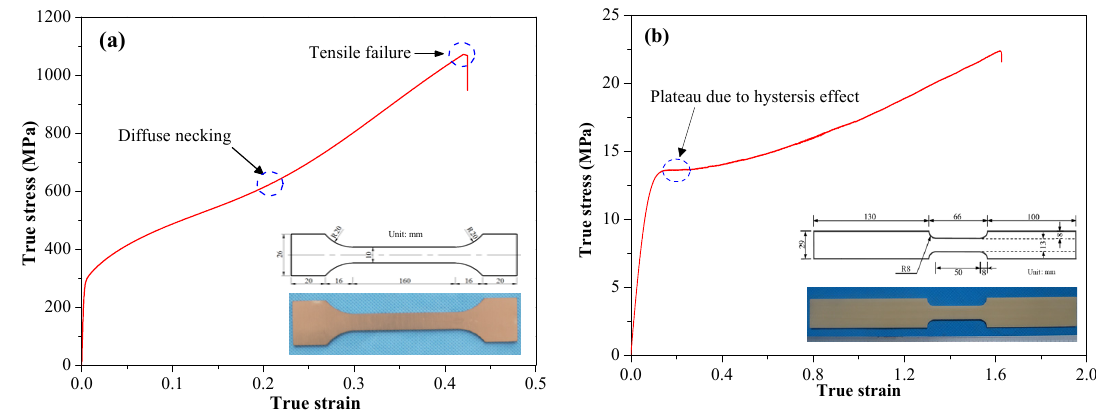
Figure 3. Quasi ‐ static true stress–strain curves of ( a ) 304 stainless steel and ( b ) LINE XS ‐ 350 specimens.